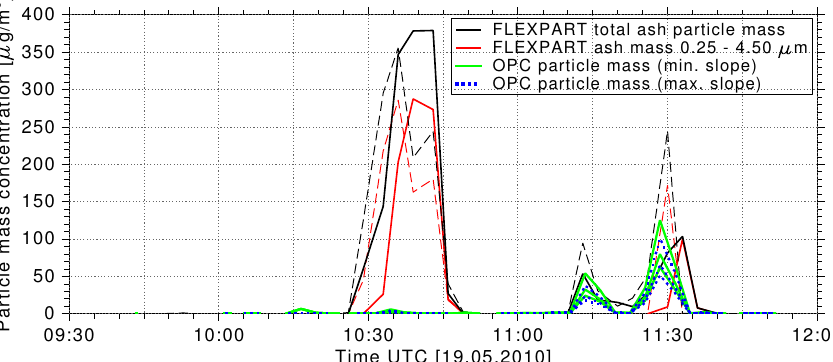
Fig. 12. Comparison of OPC measured ash concentrations with simulations from the FLEXPART model for the CARIBIC flight on 19 May 2010. The green lines indicate the particle mass concentrations derived from the OPC measurement using the smallest slope for the size distribution extrapolation (blue dotted lines using the largest slope). The three lines are calculated assuming different refractive indices for the volcanic ash particles (see text). The simulated FLEXPART total ash particle mass is shown by the black line. The red line shows the simulated FLEXPART ash particle mass in the size range 250nm–4.5µm. The black and red dashed lines show the corresponding FLEXPART ash particle masses for the altitude bin below the CARIBIC flight